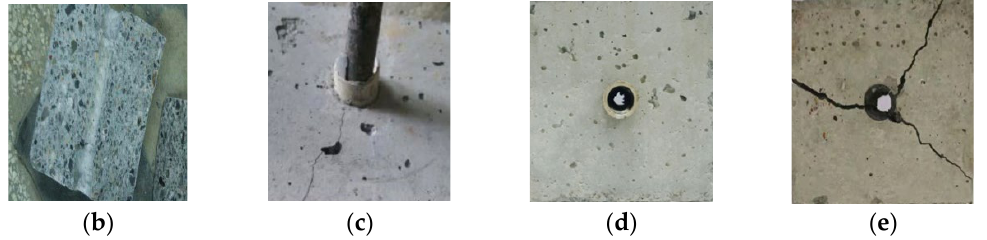
Figure 4. The failure modes of CRB and PSB specimens, respectively. ( a ) SF for CRB; ( b ) POF for CRB; ( c ) POF for PSB; ( d ) POF for PSB; ( e ) POF for CRB.